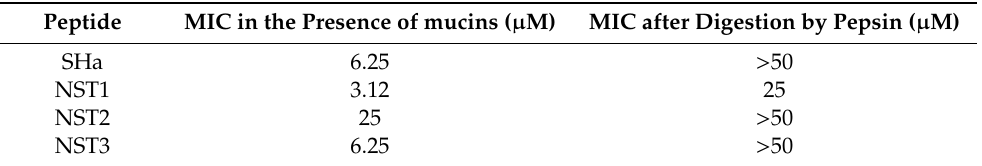
Table 6. Evaluation of the impact of mucins or pepsin on the activity of temporin-SHa, NST1, NST2, NST3. The impact of gastric factors (mucus, acidic pH, and pepsin) on the activity of temporin-SHa and its analogs on H. pylori (ATCC 43504) was evaluated as explained in Materials and Methods. Peptide MIC in the Presence of mucins ( µ M) MIC after Digestion by Pepsin ( µ M)